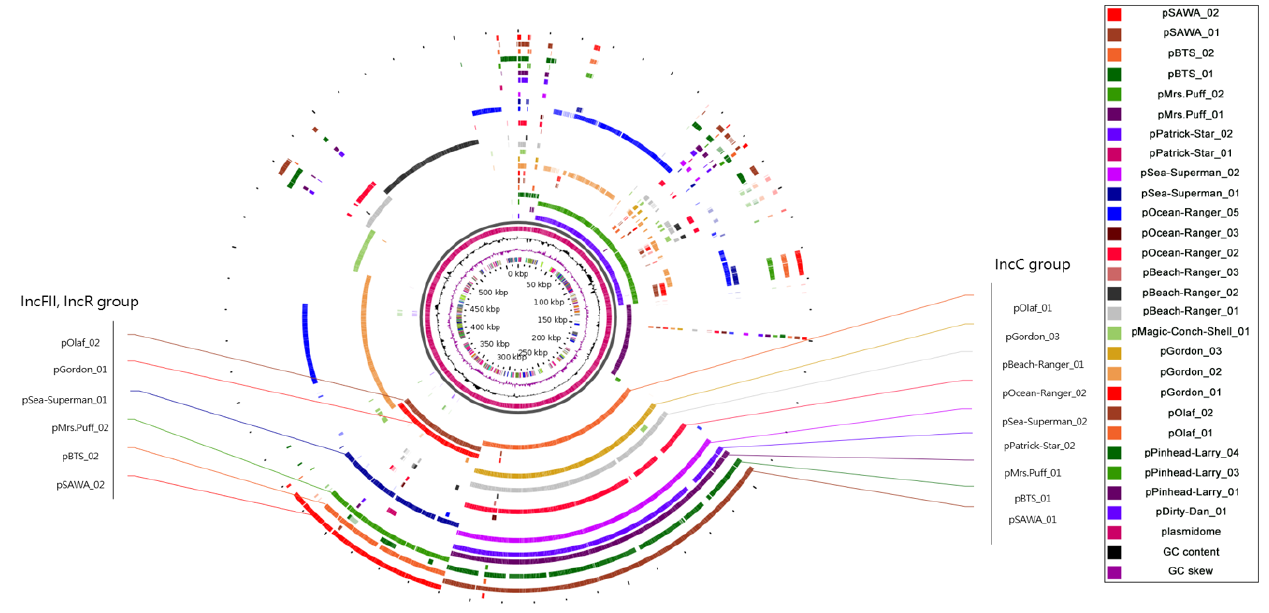
Figure 3. Plasmidome analysis of 26 complete plasmids from K pneumoniae genomes in the study. Plasmidome was constructed by concatenating the core genes of all plasmids. The core genes in each plasmid are depicted in different colors to indicate their individual presence. Two plasmid groups, IncF22/IncR and IncC, sharing common core genes are highlighted.